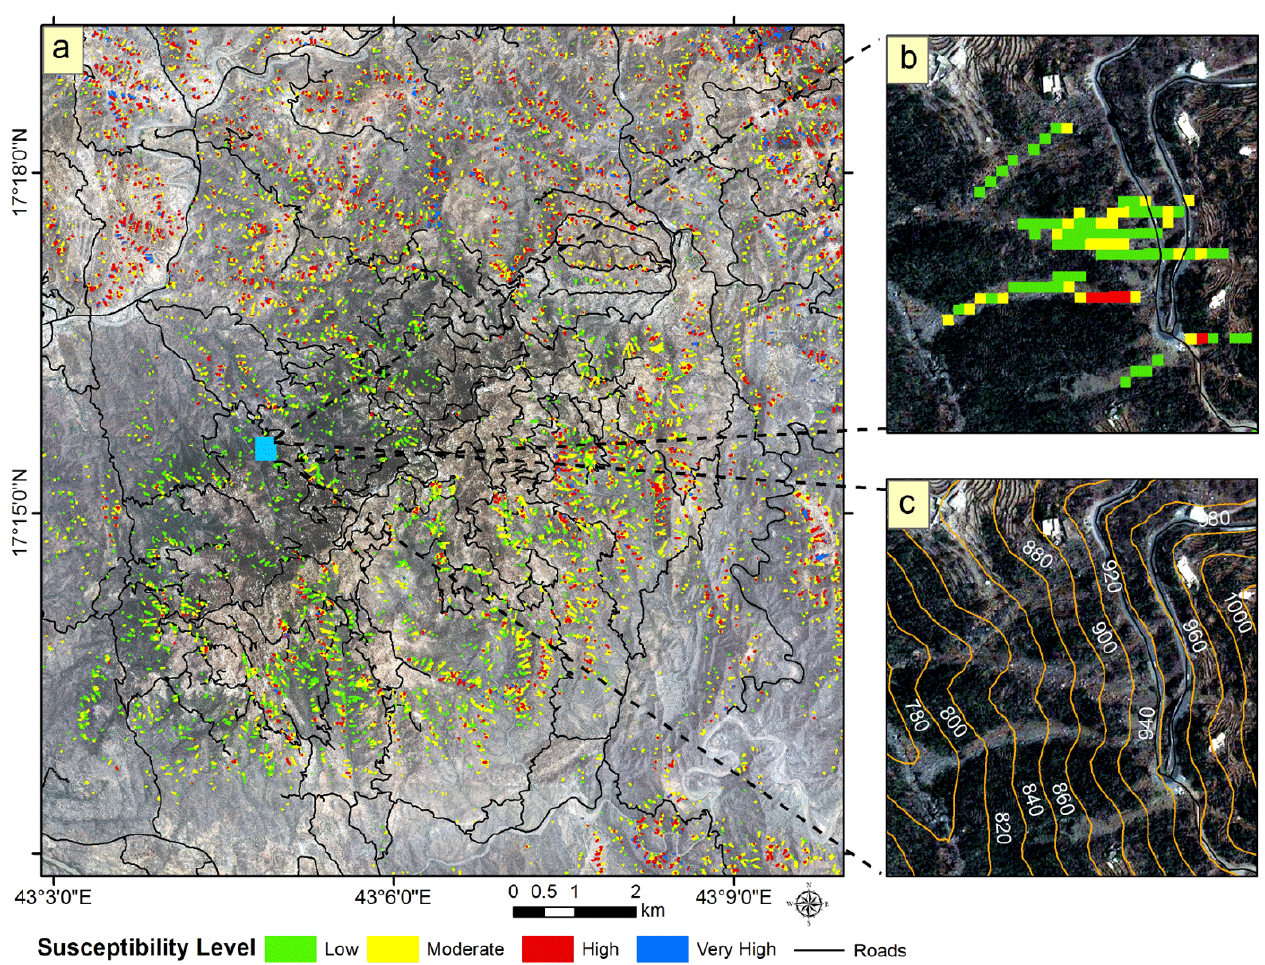
Figure 6. (a) Susceptibility map showing the susceptibility level for areas modeled as being prone to debris flow. (b) Enlargement of the boxed area in (a) . (c) Same as (b) , but with the modeled debris flow omitted. Note the correspondence between the modeled (b) and observed ( c : bright areas) debris